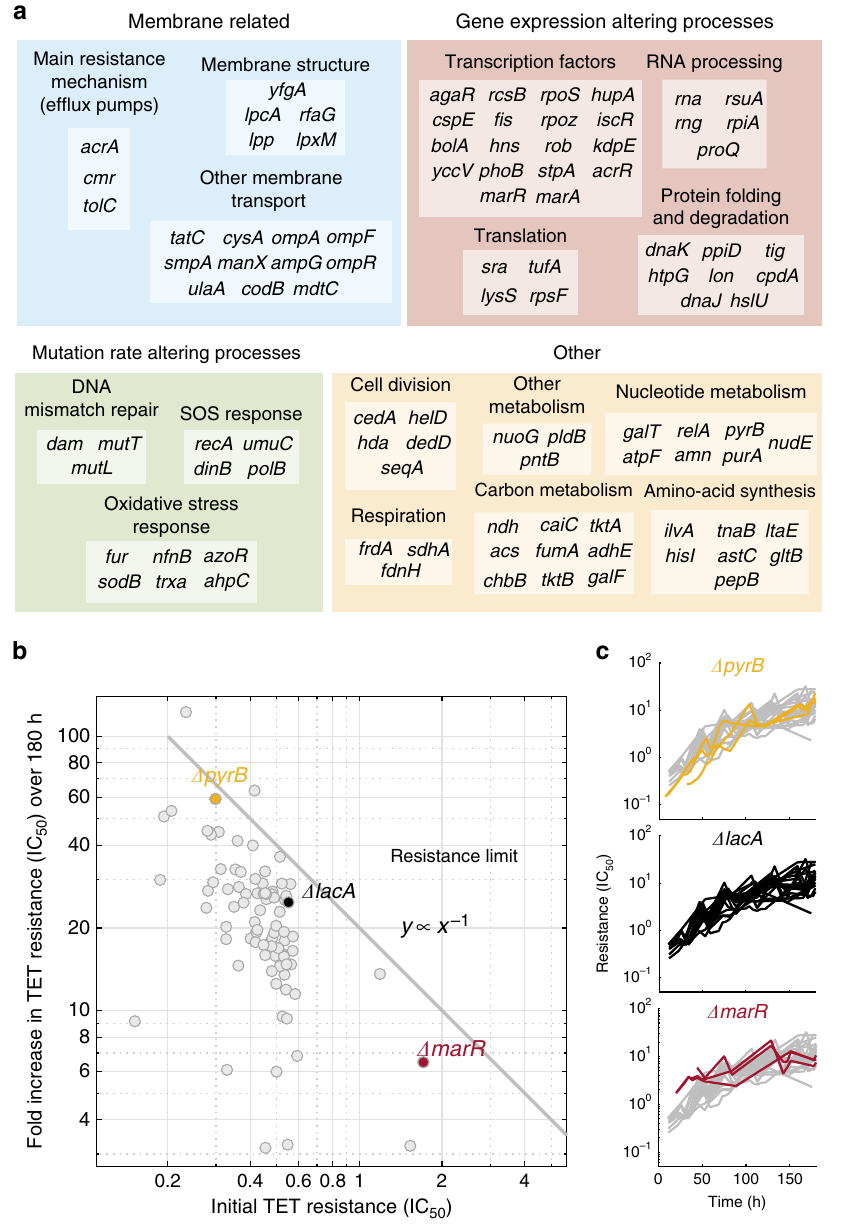
Fig. 2 Resistance increases in gene-deletion strains exhibit hallmarks of diminishing-returns epistasis. a Gene deletions chosen as ancestors for evolution experiments grouped by possible mechanism of evolvability alteration (large colored boxes) and speci fi c cellular function (small boxes). b Mean fold increase in resistance after 180 h of evolution versus initial resistance for each deletion strain. The fi nal and initial resistance measures for each replicate are the mean tetracycline concentrations over appropriate time intervals (12 – 24 h for initial and 170 – 180 h for fi nal resistance). The line y ∝ x − 1 indicates where the points would lie if all experiments reached the same fi nal resistance irrespective of initial resistance. There is a strong anti-correlation (Spearman ’ s ρ = − 0.544, bootstrap 95% con fi dence interval [ − 0.735 − 0.302], p = 2 × 10 − 7 ) indicating diminishing returns; bias of ρ (estimated by bootstrapping) is at most 0.005. c Yellow, black, and red lines show resistance change over time for replicates of the three strains highlighted in the same color in ( b ), respectively; resistance change of 22 replicates of the reference strain ( Δ lacA ) are shown in gray for comparison. This fi gure uses data from experiment M2 in panel b and combines data from M2 and M3 in panel c (Methods, Supplementary Table 2, Source